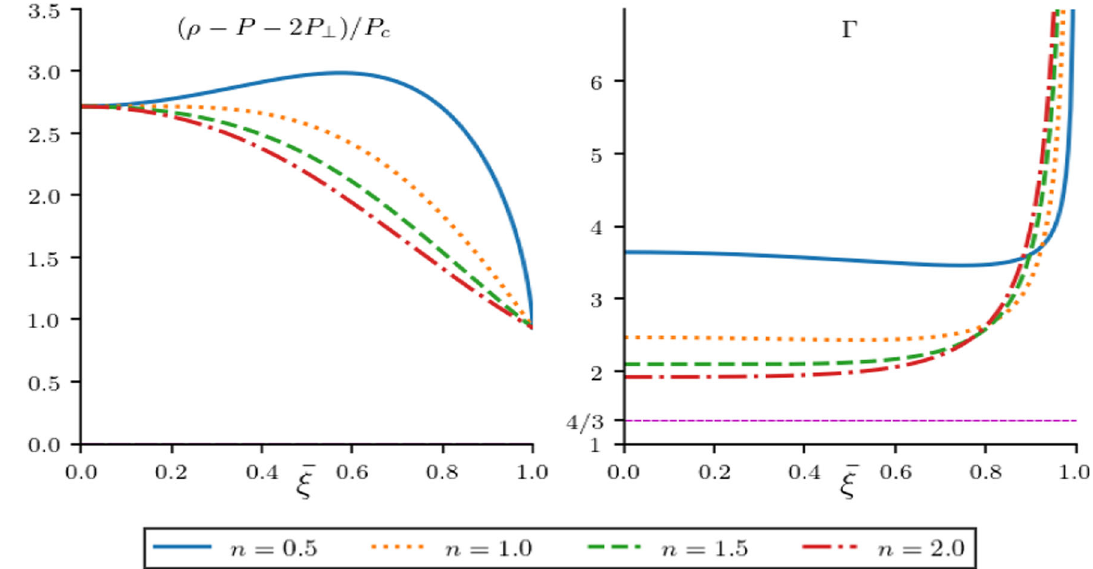
C = 0 . 05 for several values of n . From these plots it is clear that the models considered comply both C4 and C5 criteria for various poly- tropic